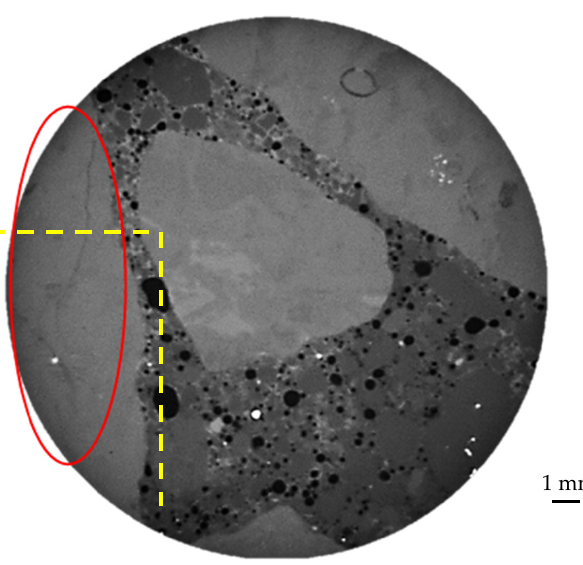
Figure 8. Examples of two cracked samples ( a ) concentration profiles in sample 2; ( b ) concentration profiles in sample 13.